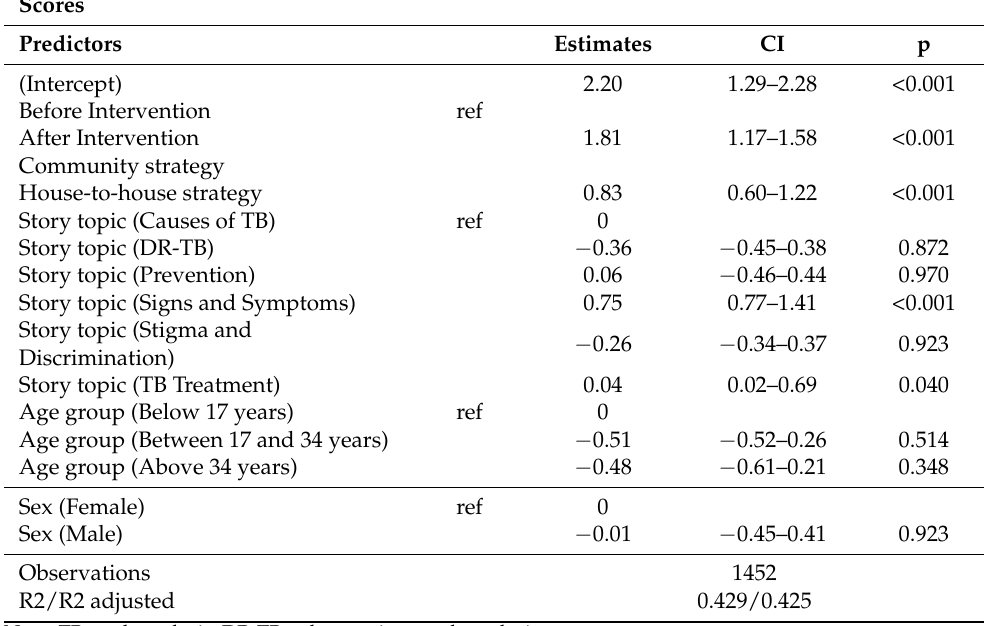
Table 4. Multivariate regression of mean scores for TB knowledge assessment before and after digital story